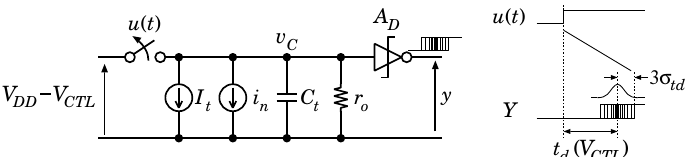
Figure 12. Timing diagram of VTC ( a ) reset state, ( b ) integration state and ( c ) conversion completed. Figure 13 plots the 100-times transient-noise simulation result of 3 σ VTC , total as a function of C t . In this design, the capacitance of the integrator was determined as C t = 521 fF and I t = 1.0 µ A to satisfy the jitter requirement.